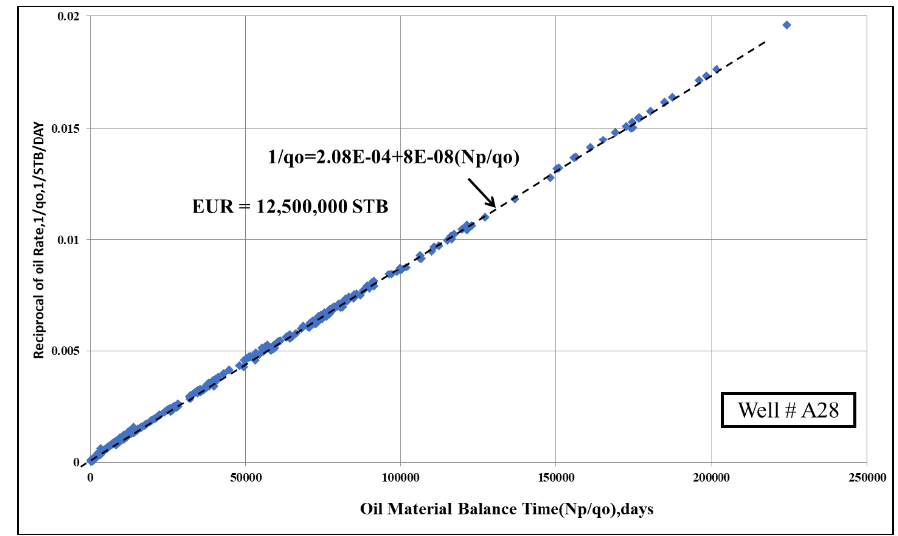
Figure 10. Reciprocal of oil rate, 𝟏/𝒒 𝒐 versus oil material balance time, to for well